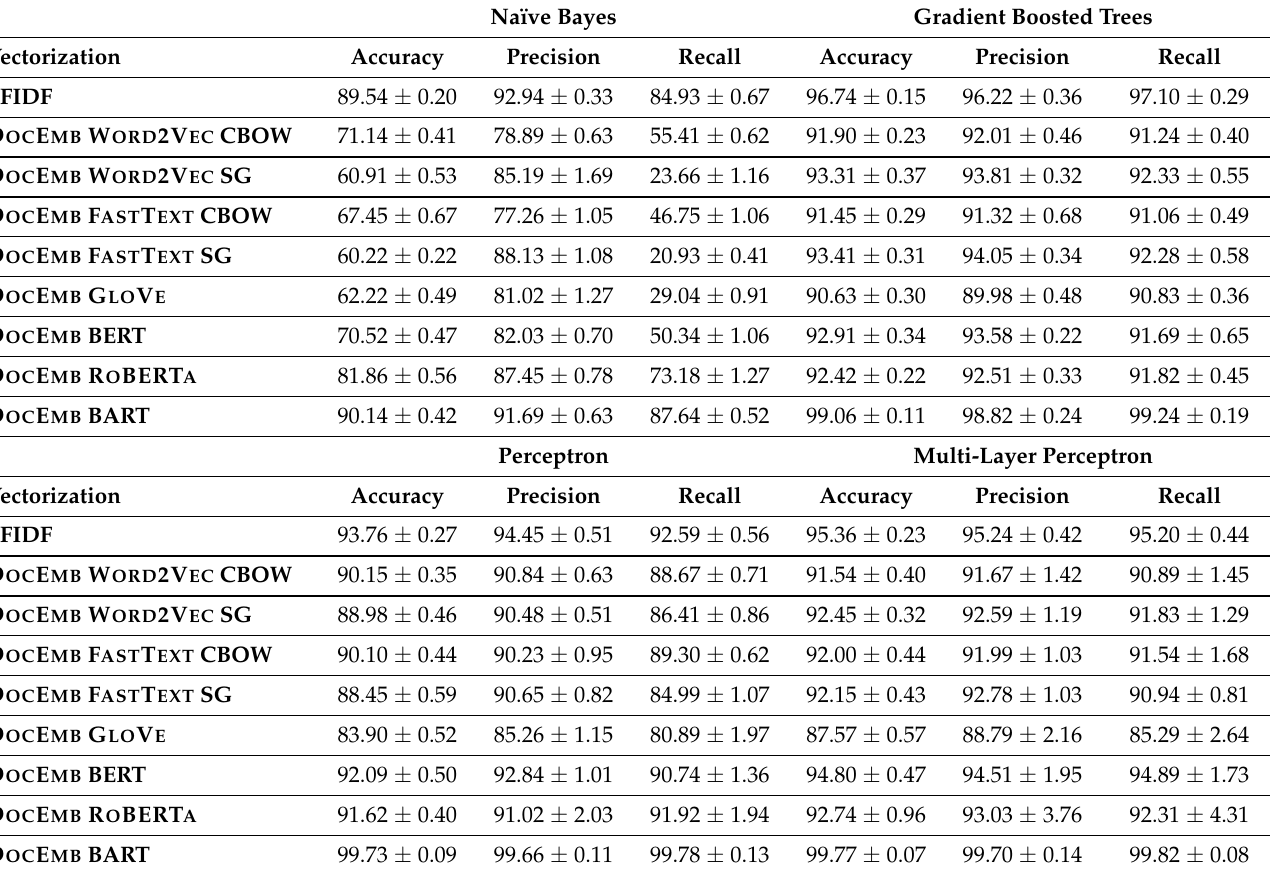
Table 5. Fake news detection results on the Kaggle dataset as presented in Kaliyar et al. [12,18]. Naïve Bayes Gradient Boosted